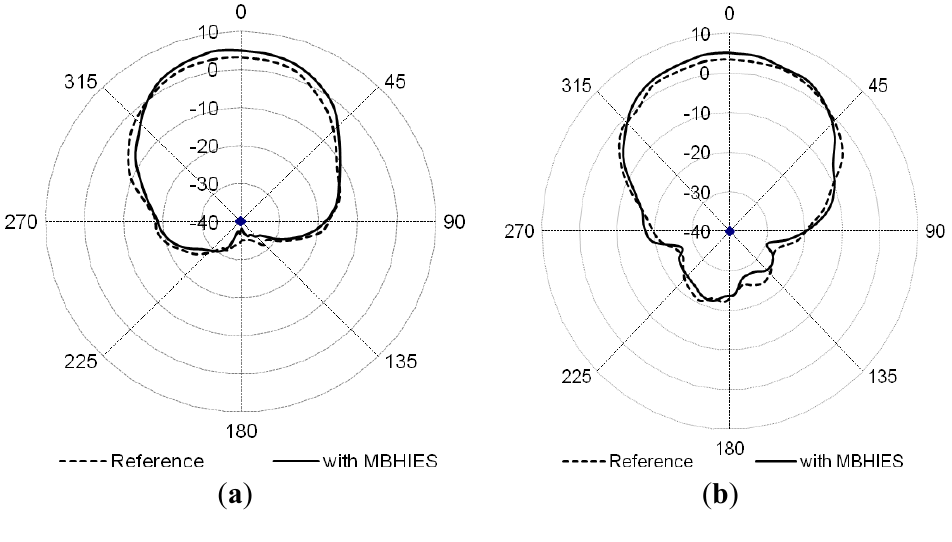
Figure 12. Gain patterns of the array with and without MBHIES at 3.8 GHz: ( a ) E-plane; ( b )